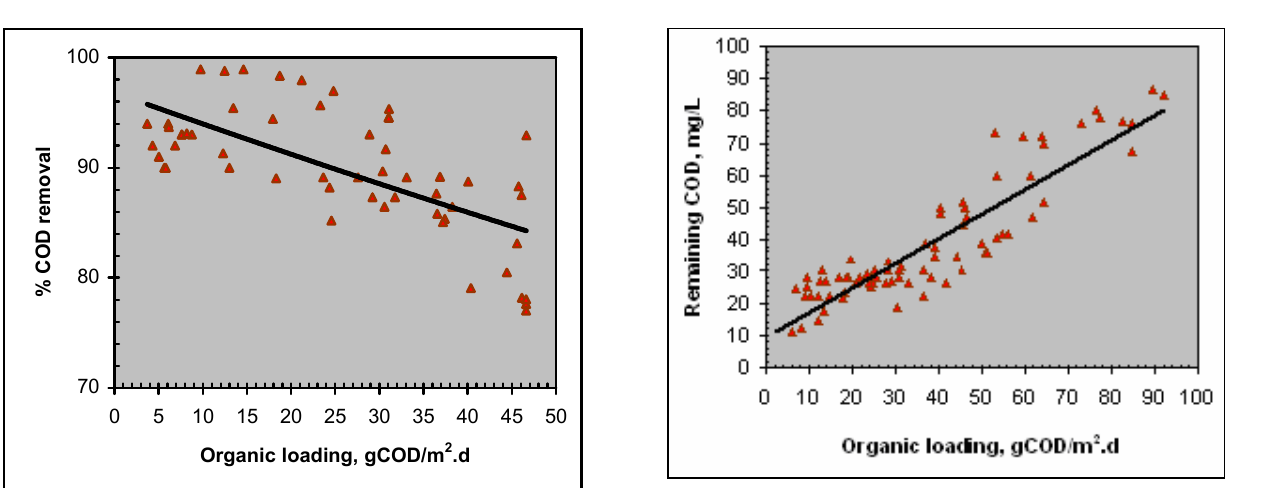
Figure 10: Effect of organic loading on the COD removal efficiency under loading < 50 g COD/m 2 .d.